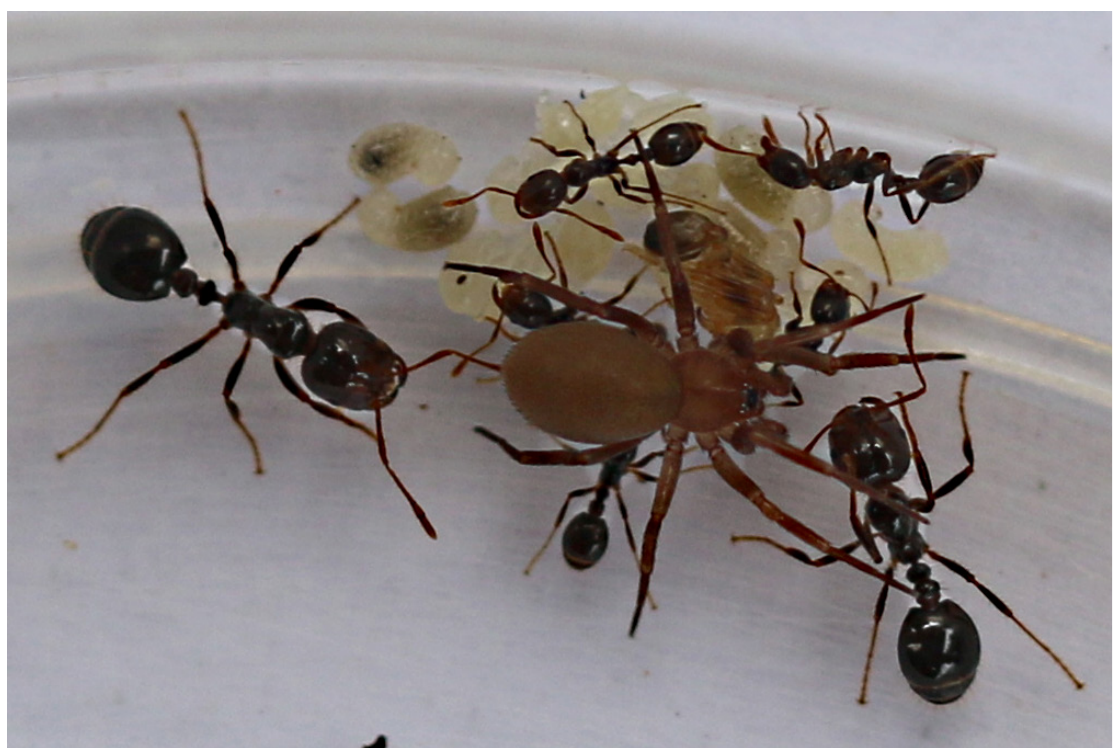
Fig 2 . Attacobius lavape female on larvae and pupae, touching and being touched by the ants in a Solenopsis saevissima colony maintained in